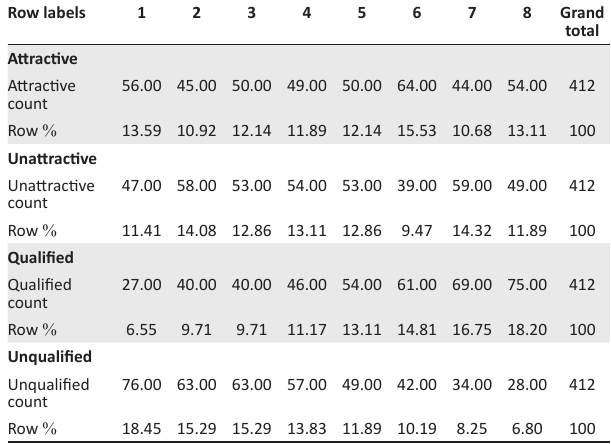
TABLE 4: Cumulative totals for candidate ranking based on qualification and attractiveness. Row labels